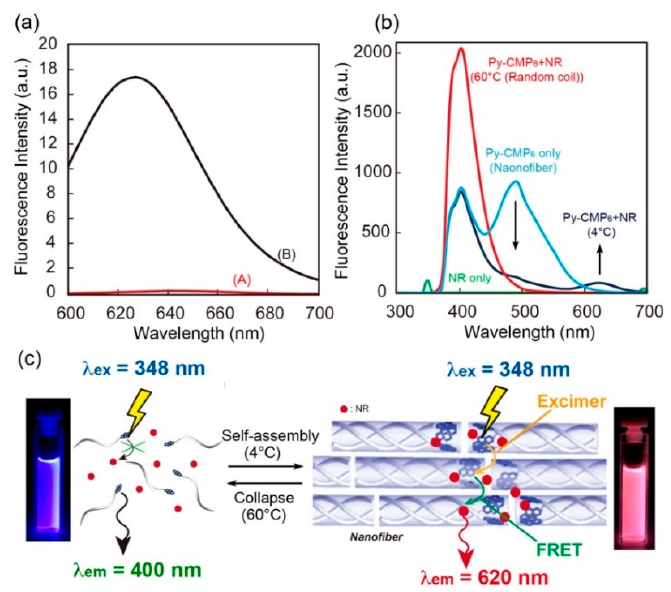
Figure 7. ( a ) Fluorescence spectra of NR (2 µ M) in the absence (A) and presence (B) of Py-CMP 6 nanofiber in water (1% EtOH, 5% TFE) at 4 ◦ C. λ ex = 580 nm. [Py-CMP 6 ] = 60 µ M. ( b ) Fluorescence spectra of NR/Py-CMP 6 nanofiber in water at 4 ◦ C and 60 ◦ C. λ ex = 348 nm. The spectra of aqueous NR and Py-CMP 6 nanofiber (4 ◦ C) are also included for comparison. ( c ) Schematic model for the conversion of energy from shorter to longer wavelengths in Py-CMP 6 nanofiber. Photographs show NR/Py-CMP 6 nanofiber aqueous solutions at 4 ◦ C (right) and 60 ◦ C (left) under UV lamp (365